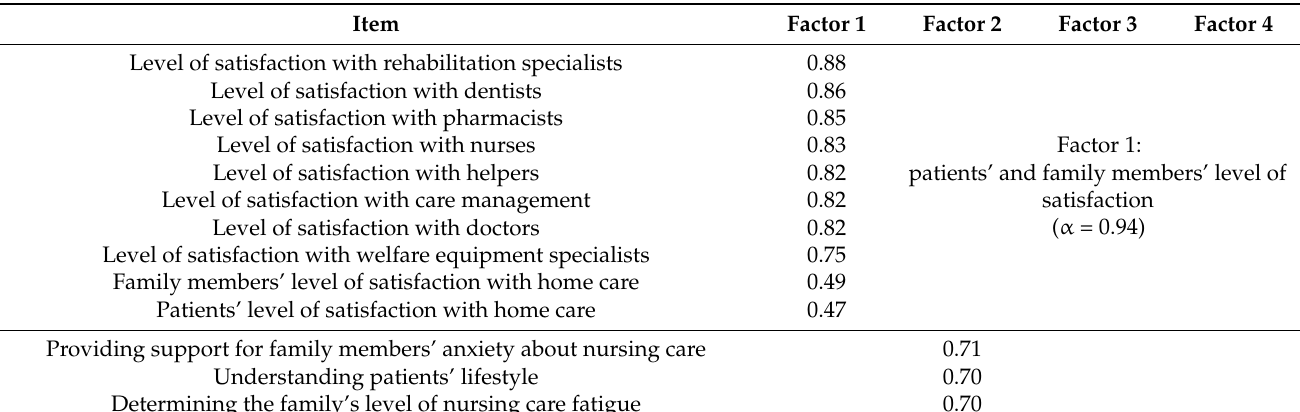
Table 3. Results of the factor analysis on the quality of home